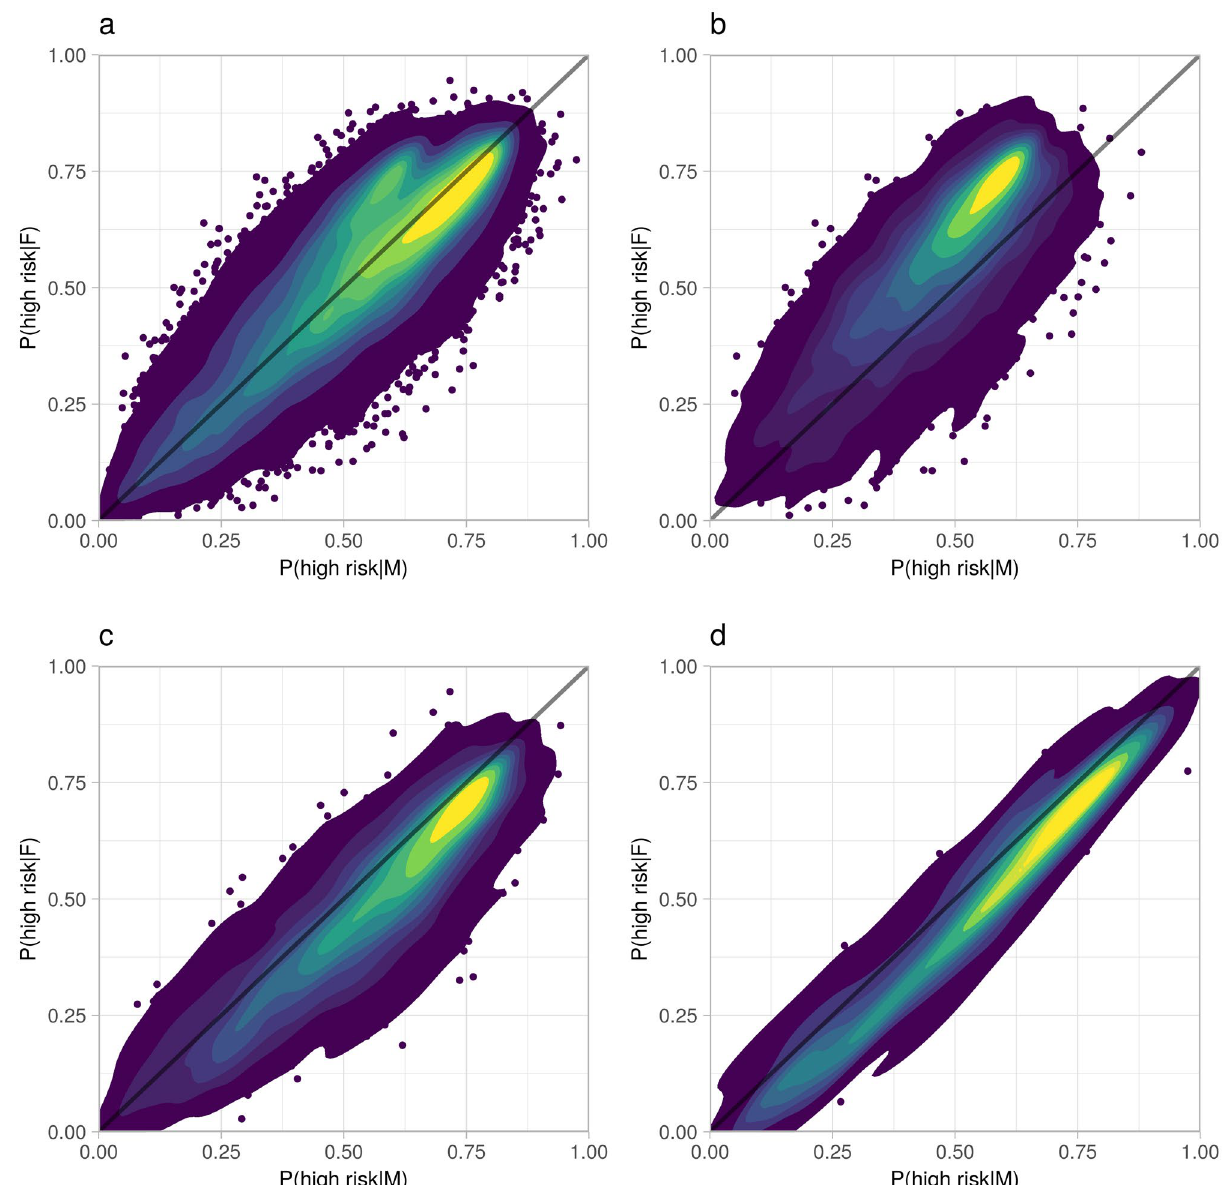
Figure 2. Higher risk coefficient posterior probability (high risk) in males versus in females, in inferred families with concordant cancer. ( a ) All sites, ( b ) lung and trachea, ( c ) colon, ( d ) thyroid gland. Contours start from ~ 99% of data points encompassed, followed by 90%, after which decrements are by each 10%. Observations remaining outside the largest contour visualised as points. Diagonal line drawn as a visual reference for equal male and female risk coefficient posterior